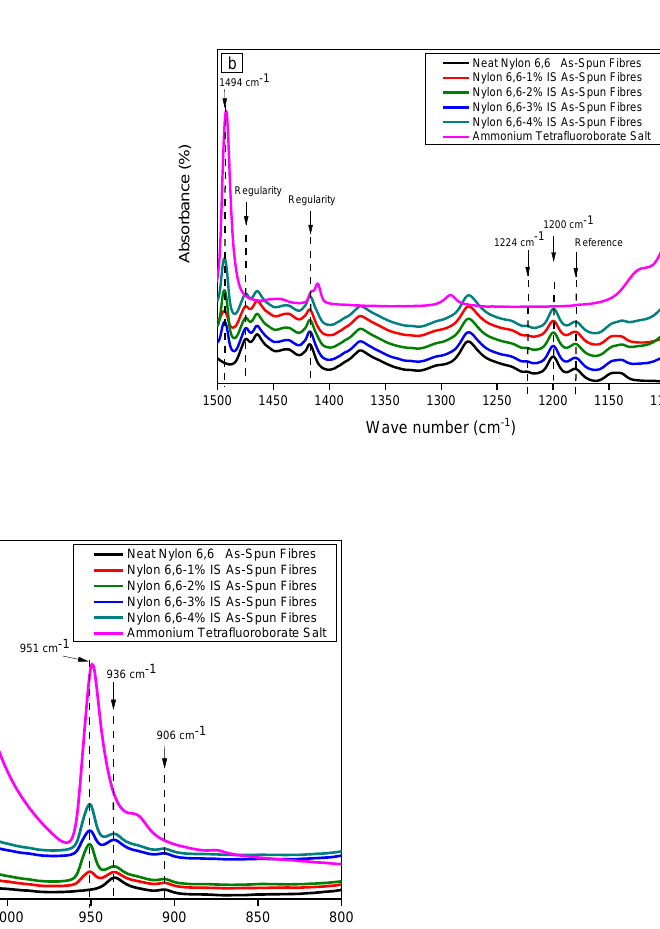
Figure 1. The FTIR spectra of the as-spun neat and salt-confined nylon 6,6 fibres in the band regions of ( a ) 4000 – 600 cm − 1 , ( b ) 1500 – 1100 cm − 1 and ( c ) 1100 – 800 cm − 1 .